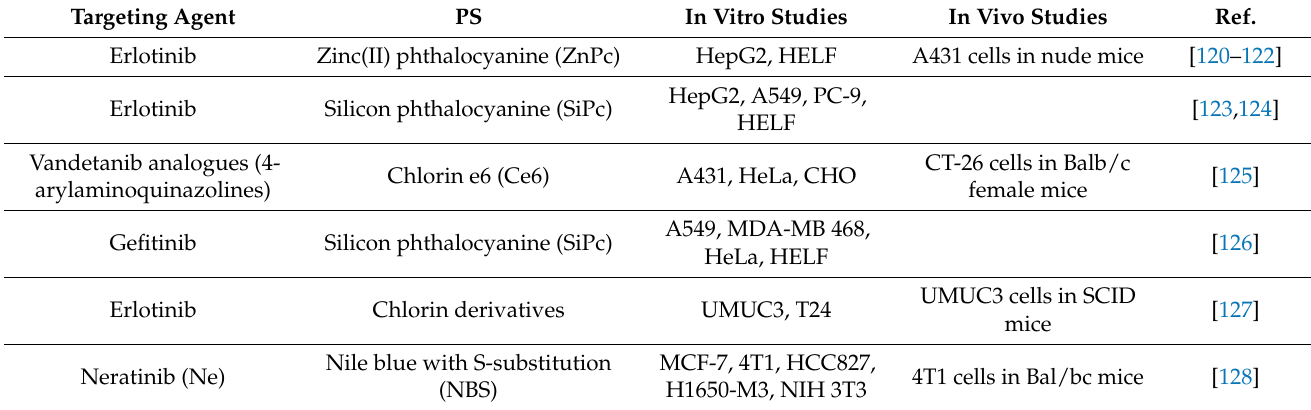
Table 5. EGFR-targeted PDT performed with EGFR ligands as targeting